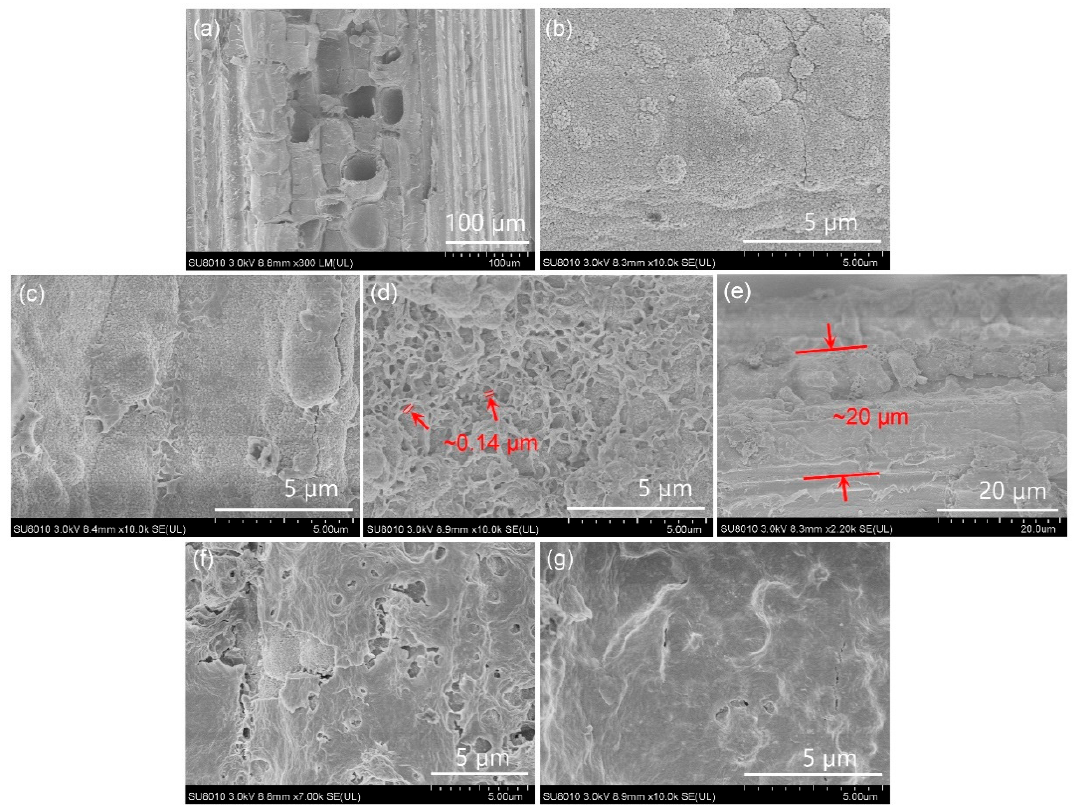
Figure 1. SEM images of ( a ) pristine bamboo; ( b ) TiO 2 -B and ZnO/TiO 2 -B with different concentrations of Zn(NO 3 ) 2 during the coating process: ( c ) 0.05 M ZnO/TiO 2 -B, ( d ) 0.1 M ZnO/TiO 2 -B; ( e ) The cross-section of the coating of 0.1 M ZnO/TiO 2 -B; ( f ) 0.2 M ZnO/TiO 2 -B; and ( g ) 0.3 M ZnO/TiO 2 -B.